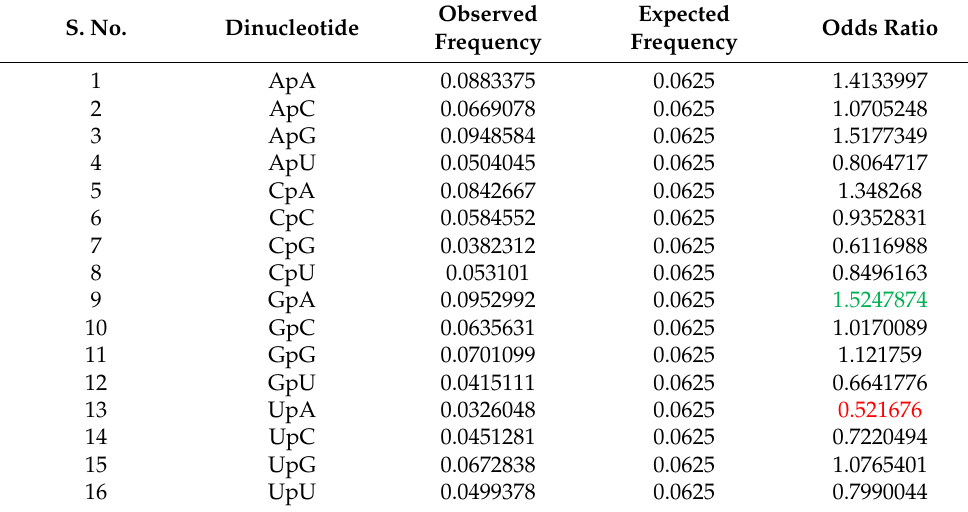
The odds ratio values highlighted with green and red fonts correspond to the maximum and minimum values for the GpA and UpA dinucleotides, respectively.